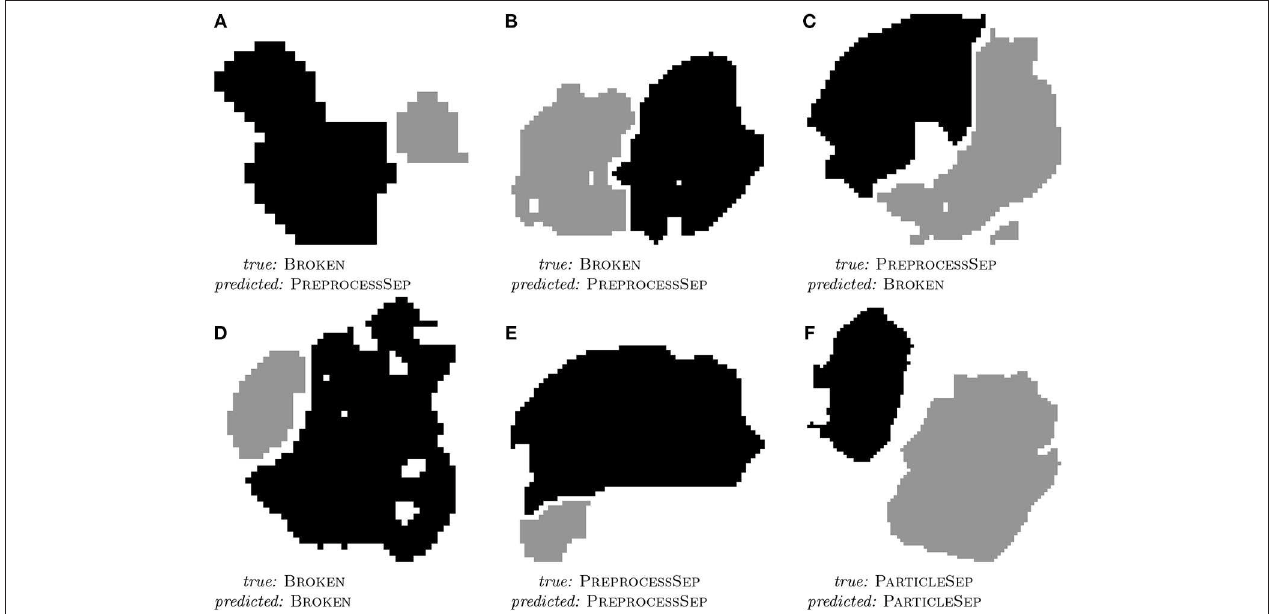
FIGURE 4 | 2D slices of three misclassified (A–C) and three correctly classified (D–F) examples of particle pairs from the hand-labeled dataset with their true and predicted class label. Reprinted from Petrich et al. (2017), Figure 11, with permission from Elsevier.